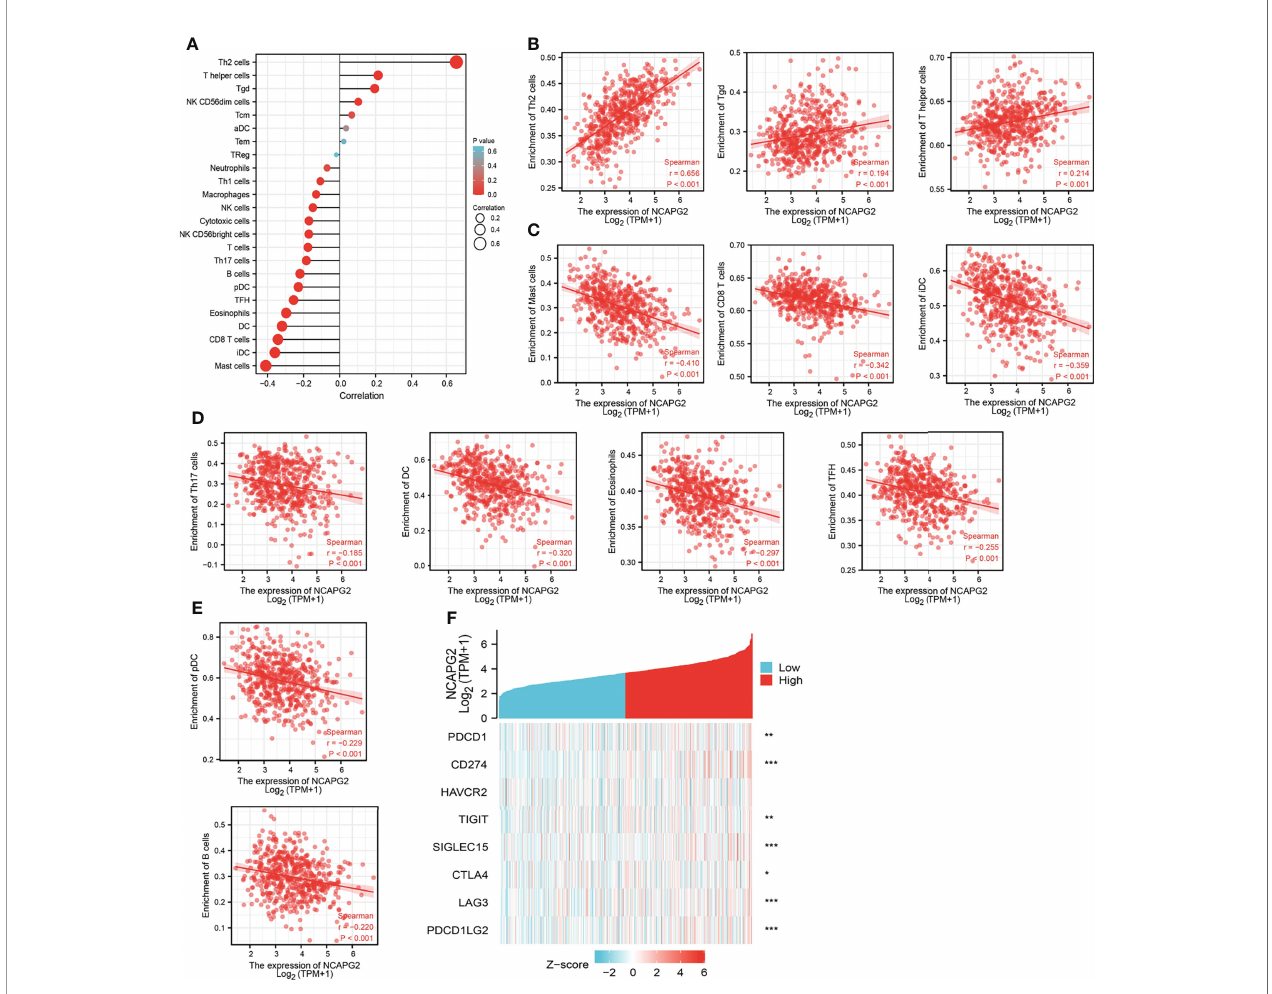
FIGURE 9 | Correlation analysis of NCAPG2 expression and in fi ltration levels of immune cells in LUAD. (A – E) The correlation between NCAPG2 expression and in fi ltration levels of immune cells. (F) Correlation analysis of NCAPG2 expression and immune checkpoint-related genes in LUAD in the TCGA